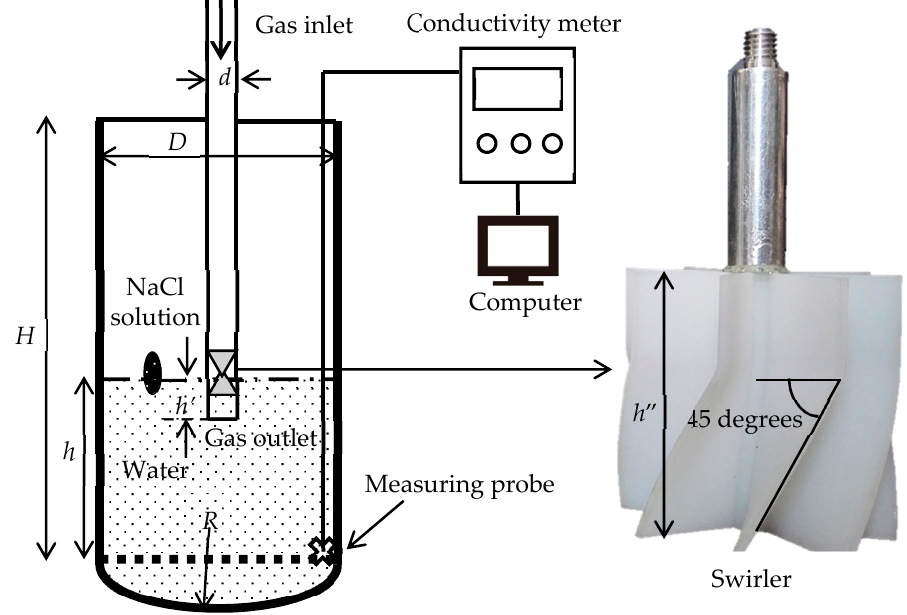
Figure 1. Schematic diagram of the water model for measuring mixing time.